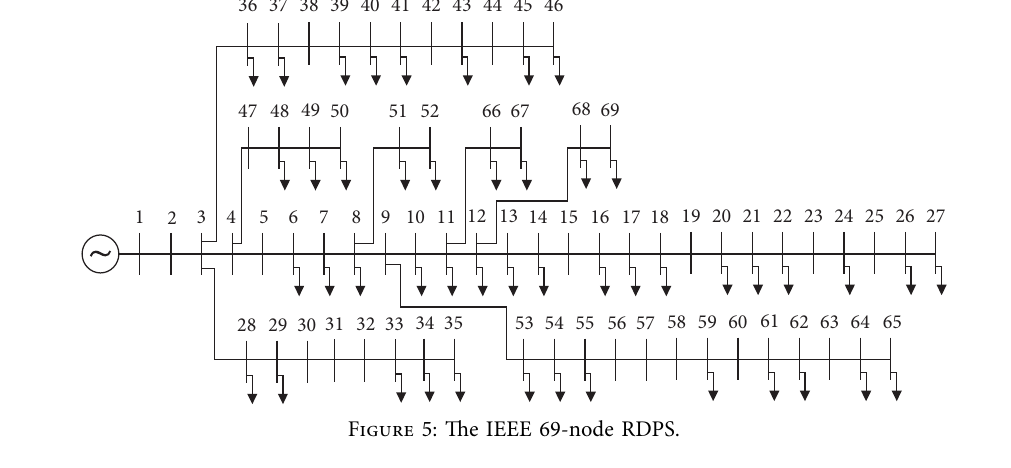
Figure 5: Te IEEE 69-node